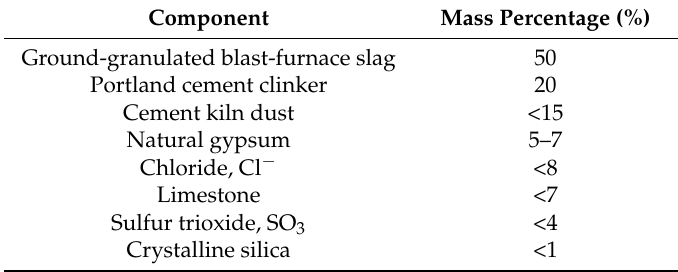
Table 3. Chemical composition of MC (as supplied by the